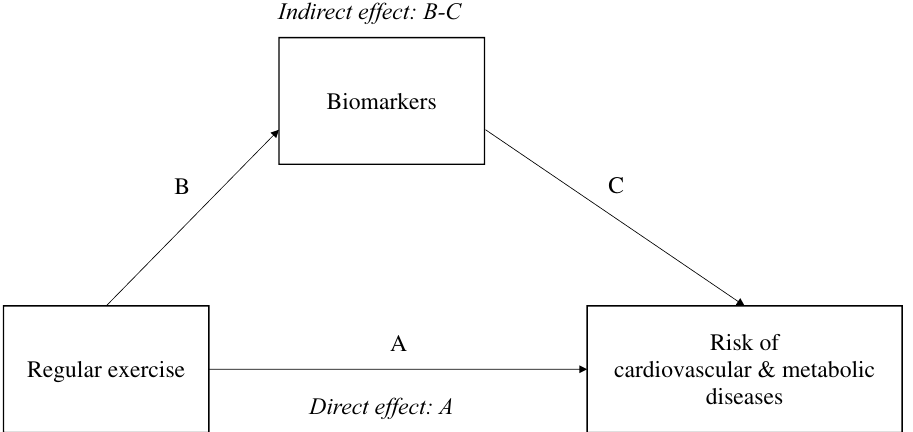
Figure 1. The conceptual diagram of mediation analysis. Direct effect of regular exercise on the risk of cardiovascular & metabolic conditions (CMD) is path A. Indirect effect of regular exercise on the risk of CMD mediated by each biomarker is path B and